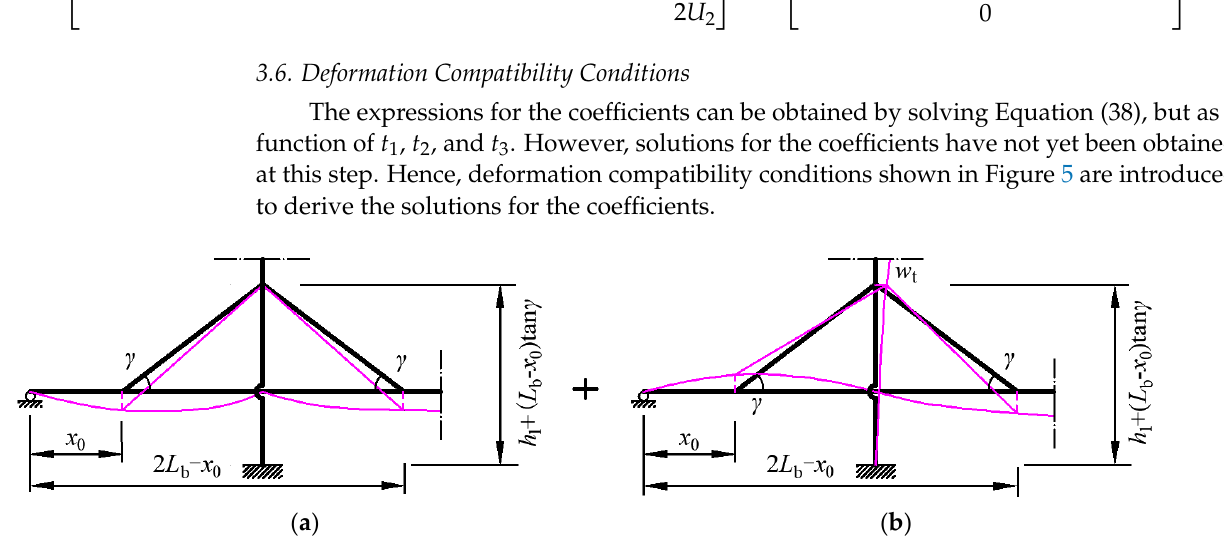
Figure 5. Deformation compatibility conditions between the stay cables and girder. ( a ) Displacement caused by elongation of stay cables. ( b ) Displacement caused by pylon deformation.